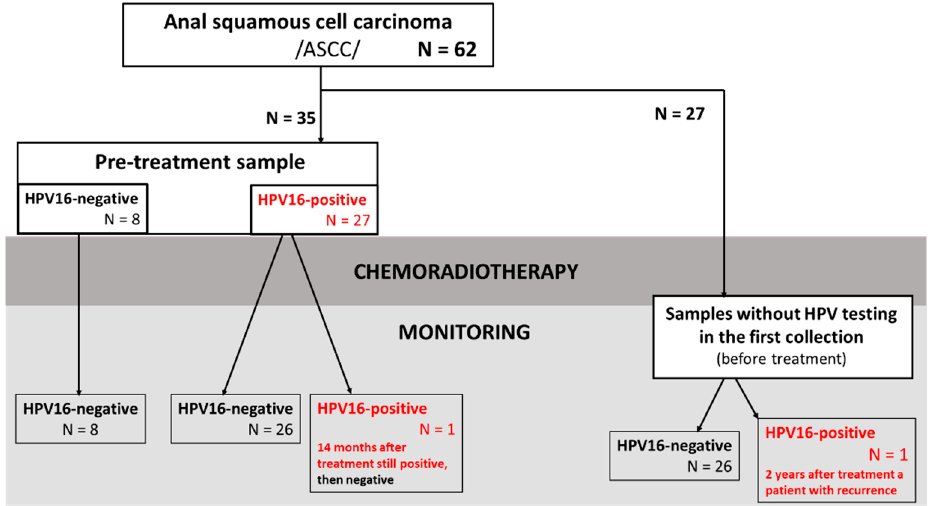
Figure 1. Scheme of availability of blood samples from patients with ASCC used for ctHPV16 testing and disease monitoring.